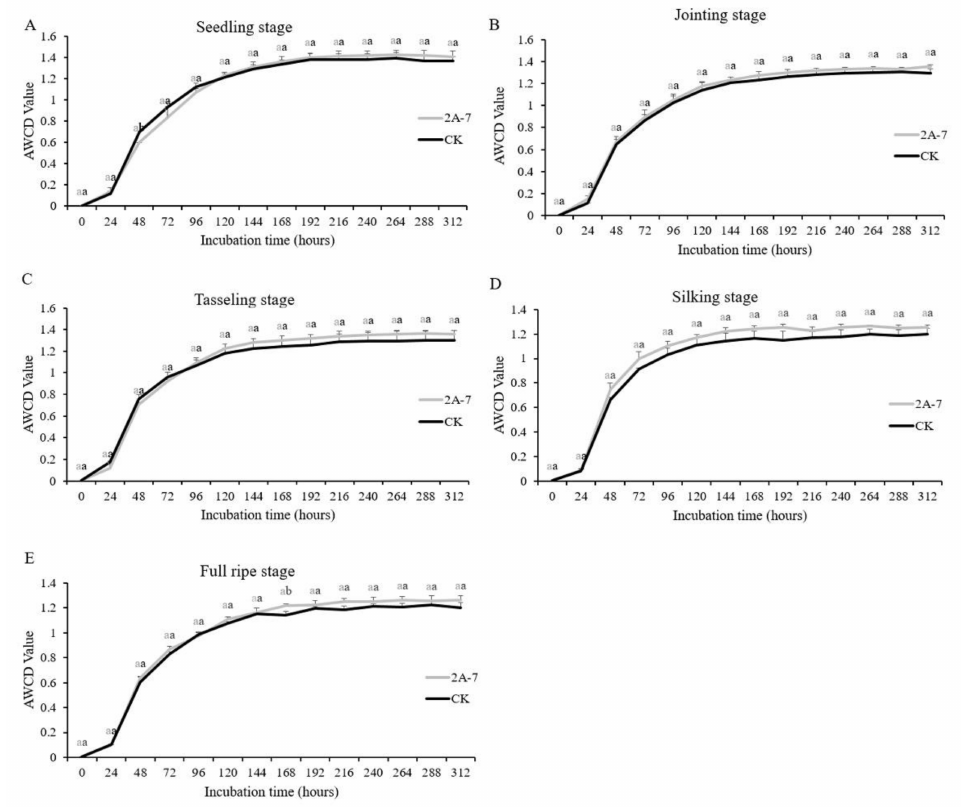
Figure 2. Changes in the microbial average well color development (AWCD) values of the rhizosphere soils of transgenic maize 2A-7 and its non-transgenic control during different developmental periods.